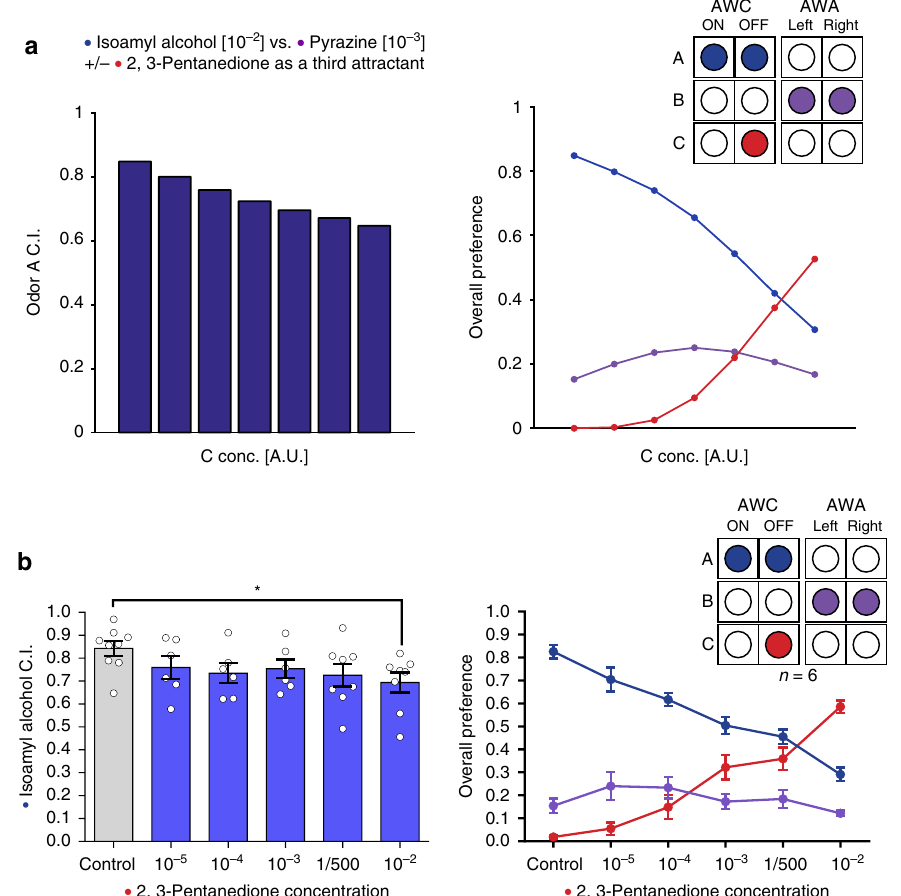
Fig. 5 Increasing concentrations of 2,3-pentanedione (AWC OFF -sensed odor) as a third alternative can induce IIA violations. a Model-predicted IIA violation driven by AWC OFF neuron activation by odor C. Left panel: predicted preference index for odor A (isoamyl-alcohol) relative to odor B (pyrazine) at different concentrations of odor C (2,3-pentanedione). Right panel: predicted preference for all three odors. In the model, the ability of the AWC OFF neuron to generate IIA violations arises from cross-odor normalization and an equal weighting of AWC ON and AWC OFF neuron activity in the representation of odor A (isoamyl-alcohol). b The in fl uence of 2,3-pentanedione (AWC OFF ) as a third attractant on the relative preference between isoamyl-alcohol (10 − 2 ) (AWC BOTH ) and pyrazine (10 − 3 ) (AWA) (two-tailed Wilcoxon signed-ranks test, C = 10 − 5 : W = 17, q = 0.2721; C = 10 − 4 : W = 12, q = 0.1424; C = 10 − 3 : W = 13, q = 0.1424; C = 1/500: W = 19, q = 0. 0.1424; C = 10 − 2 : W = 8, q = 0.0275; n = 6). Bars represent the C.I. of odor A. Error bars represent the standard error of the mean C.I. * q < 0.05, ** q < 0.01, *** q < 0.001, and **** q <